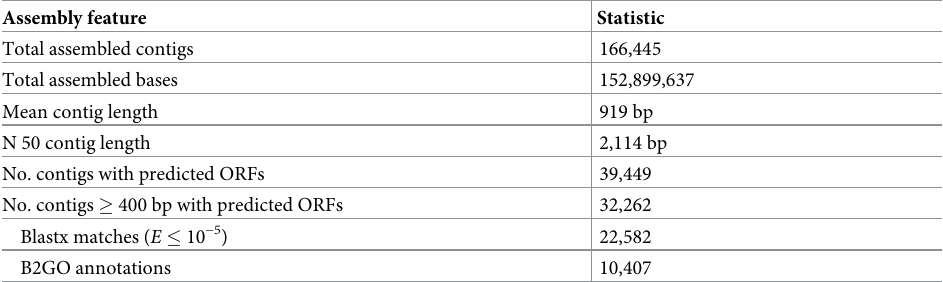
Table 1. Summary statistics for T . palmi de-novo assembled transcriptome.